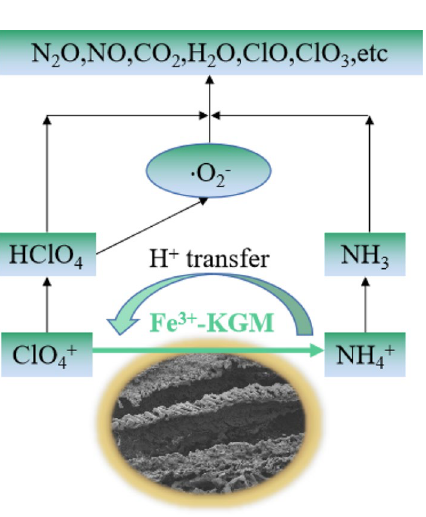
Figure 10. Schematic of the thermal decomposition process of laminated AP